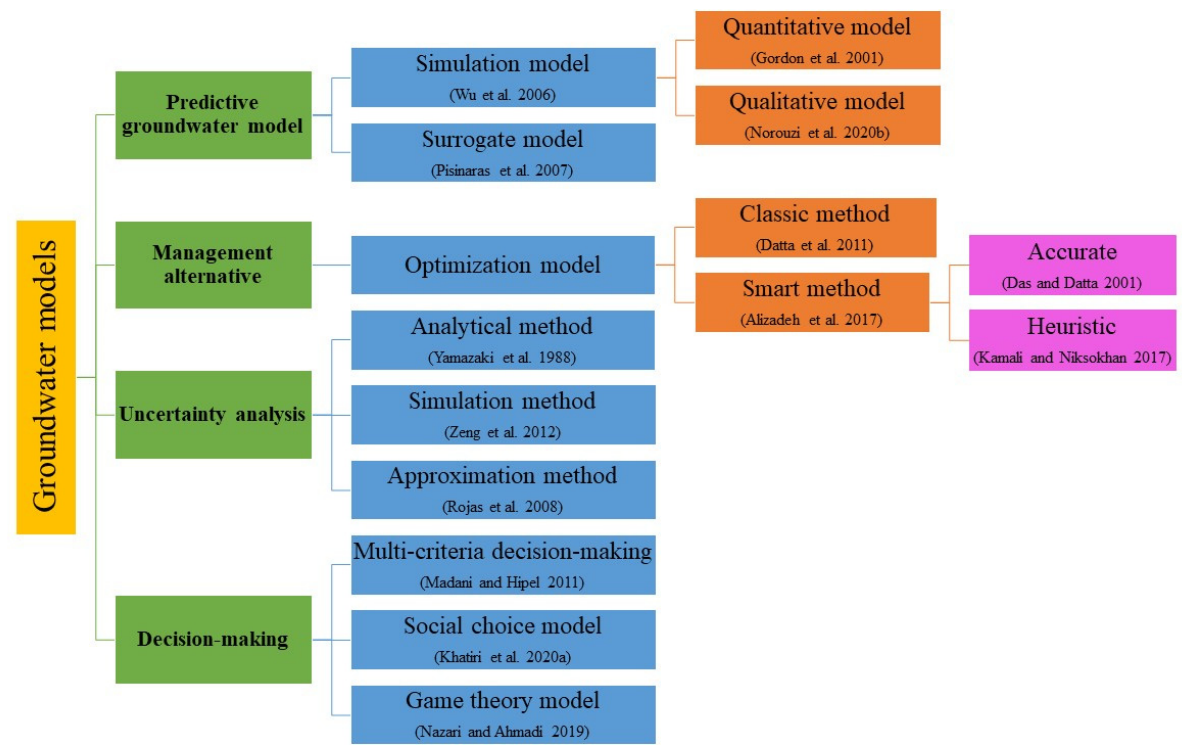
Figure 2. Categorizing the groundwater management models from different aspects [8,13,16–21].